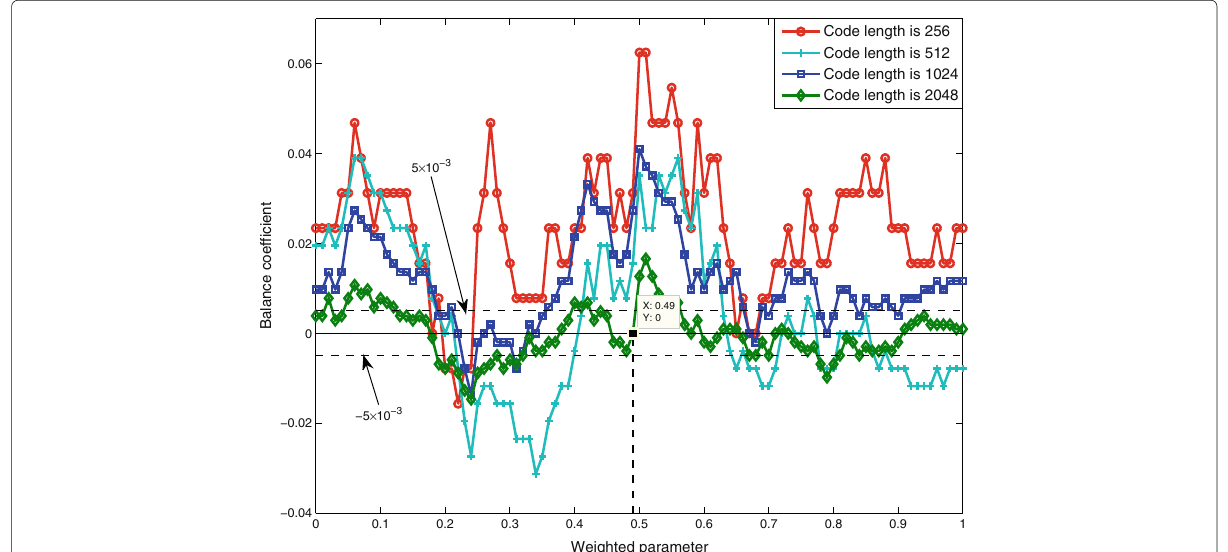
Fig. 2 Relationship between the balance coefficients of the proposed sequences and weighted parameters with various code